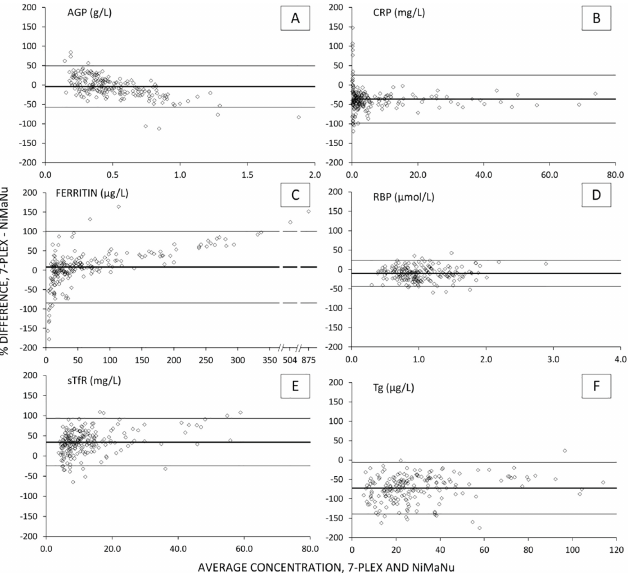
Fig 3. Bland Altman plots, 7-Plex vs NiMaNu immunoassay results. Bland-Altman plots showingpercent difference betweenthe 7-Plex and the NiMaNuconventional immunoassay results on the y-axes plotted againstaverageconcentration on the x-axes. Heavy horizontalline and light horizontal lines indicatemean ± 2 standarddeviationsof percent difference. AGP, α -1-acidglycoprotein; CRP, C-reactiveprotein; RBP, retinol bindingprotein 4; sTfR, solubletransferrin receptor; Tg, thyroglobulin.